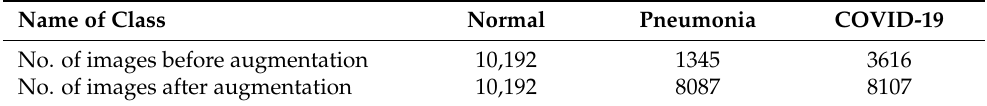
Table 2. Number of images of the training dataset before and after the augmentation technique.